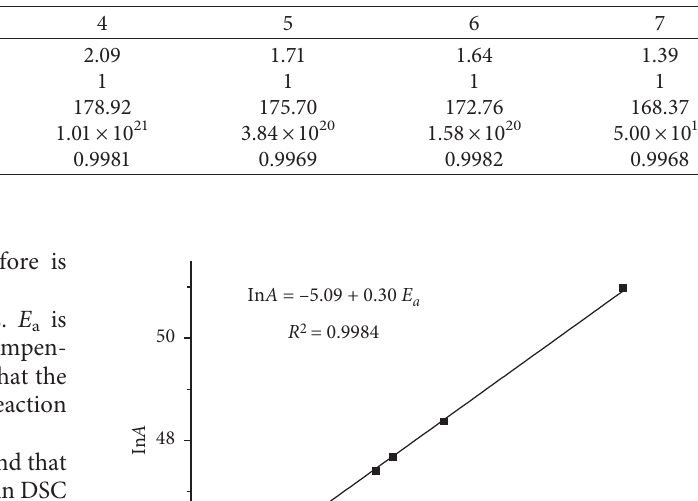
Table 8: The linear fitting results.